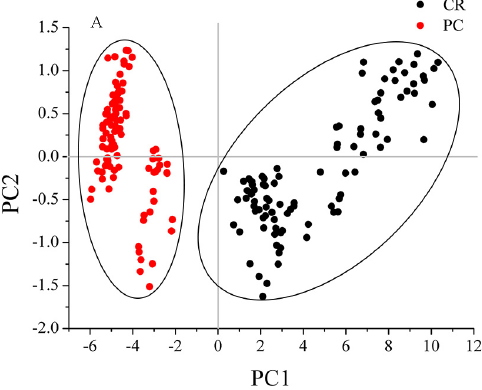
Fig. 4. Score cluster plot with top two principal components